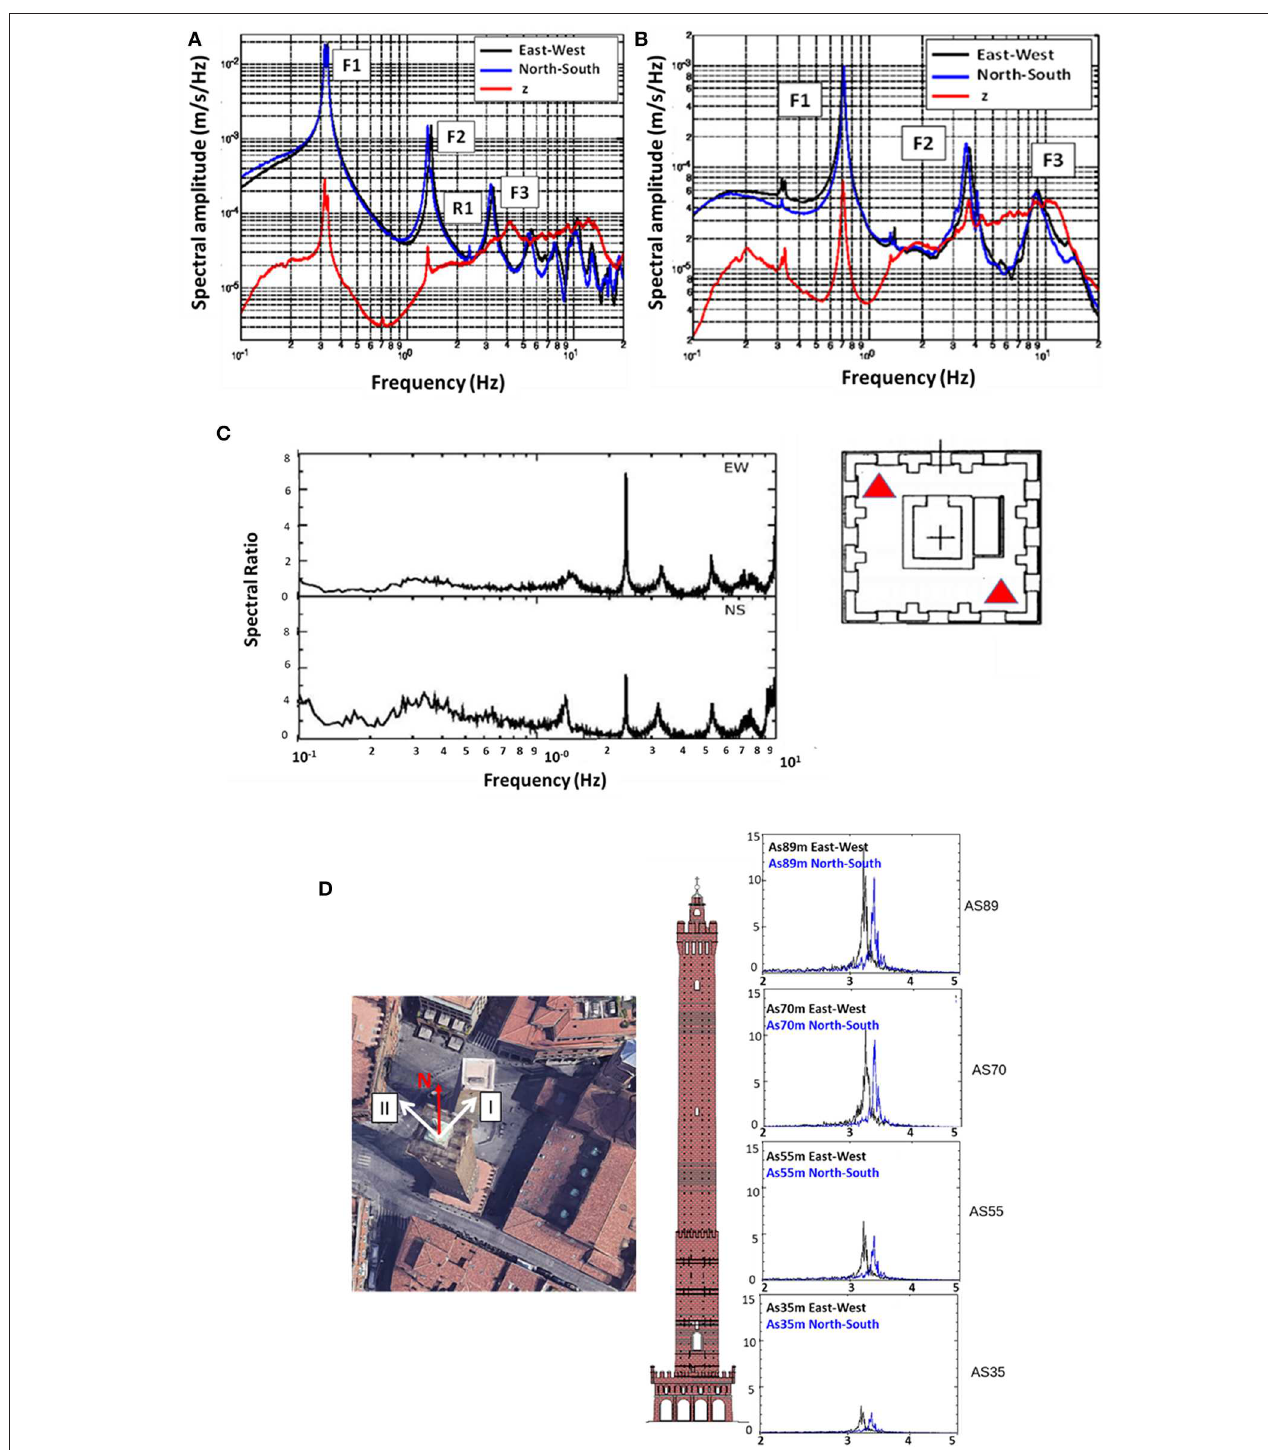
FIGURE 3 | (A) Average spectra computed over the entire monitoring period during 2013 for the top station of Asinelli Tower (B) and Garisenda Tower. (C) Experimental identification of the frequency of the torsional mode for the Asinelli Tower. On the left spectral ratio between horizontal and vertical components and on the right the position of the seismic stations on the terrace at the top of the Asinelli Tower. (D) Splitting of the fundamental frequencies. On the right separation of the horizontal spectral peaks after rotation. On the left, superimposed to an aerial view of the Towers, are shown the main axes of oscillation of the Asinelli Tower.